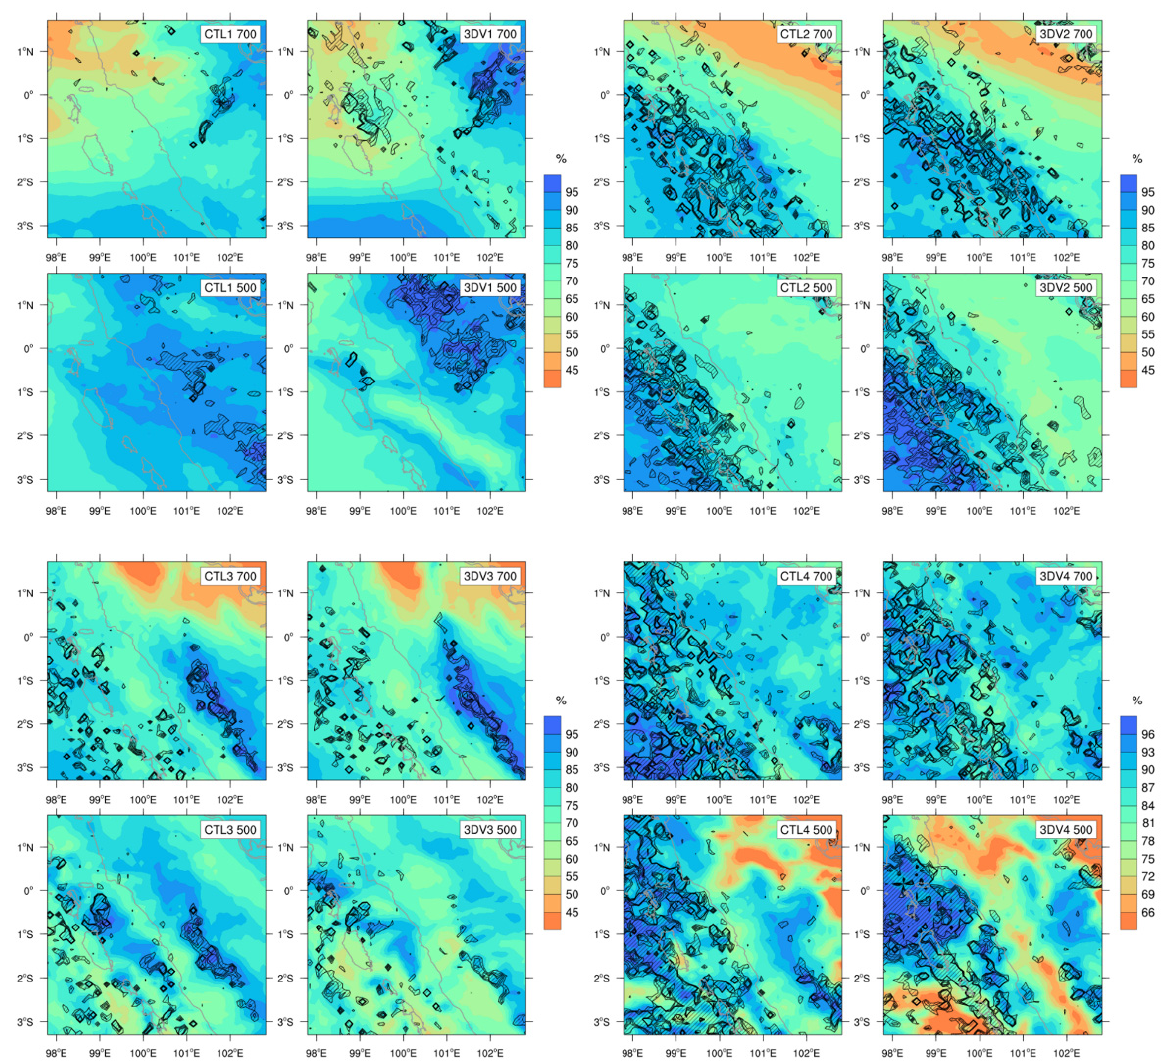
Figure 9. Relative humidity (shaded, %) and >0.05 m/s vertical motion (shaded) at 700 hPa and 500 hPa averaged from the CTL and 3DV experiments during Cases 1–4. The numbers in the panels indicate the corresponding case numbers.